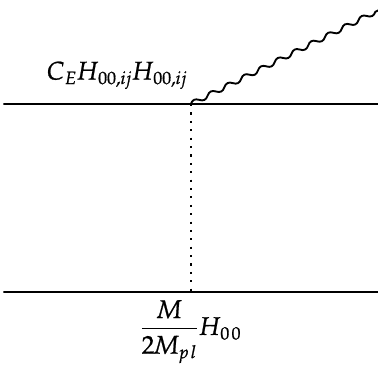
JHEP03(2023)019